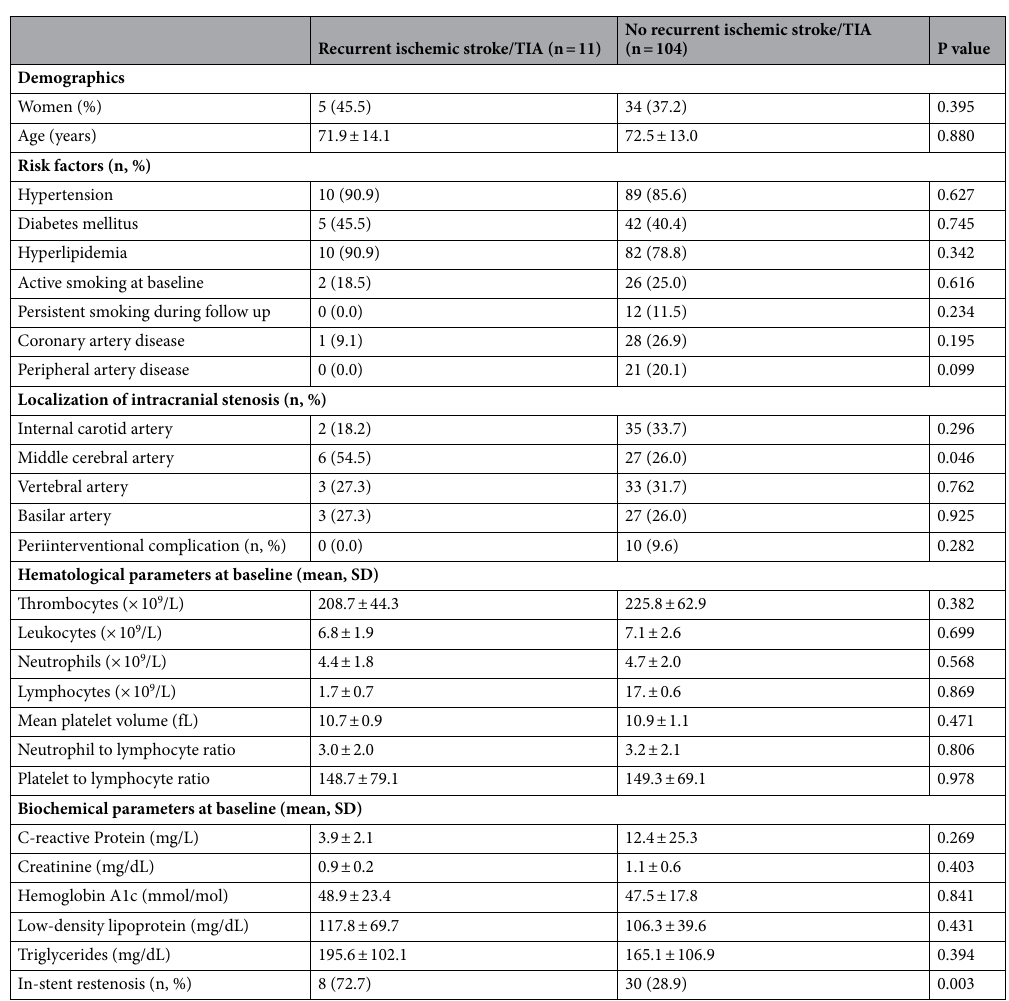
Table 3. Demographics, vascular risk profile and laboratory parameters at baseline dichotomized according to the occurrence of recurrent ischemic cerebrovascular events after stenting of symptomatic intracranial artery stenosis during a 5-year